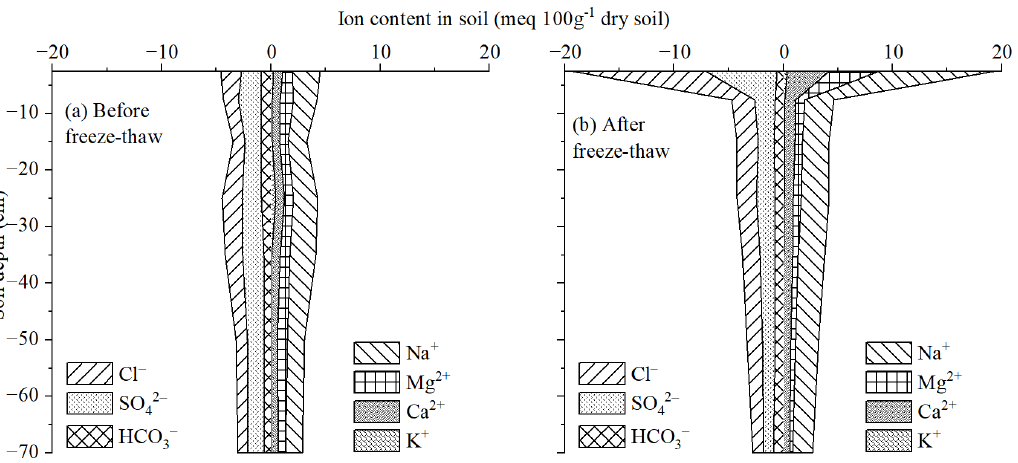
Figure 6. Profile distribution of soil soluble ion concentrations before ( a ) and after ( b ) the freeze – thaw process. thaw